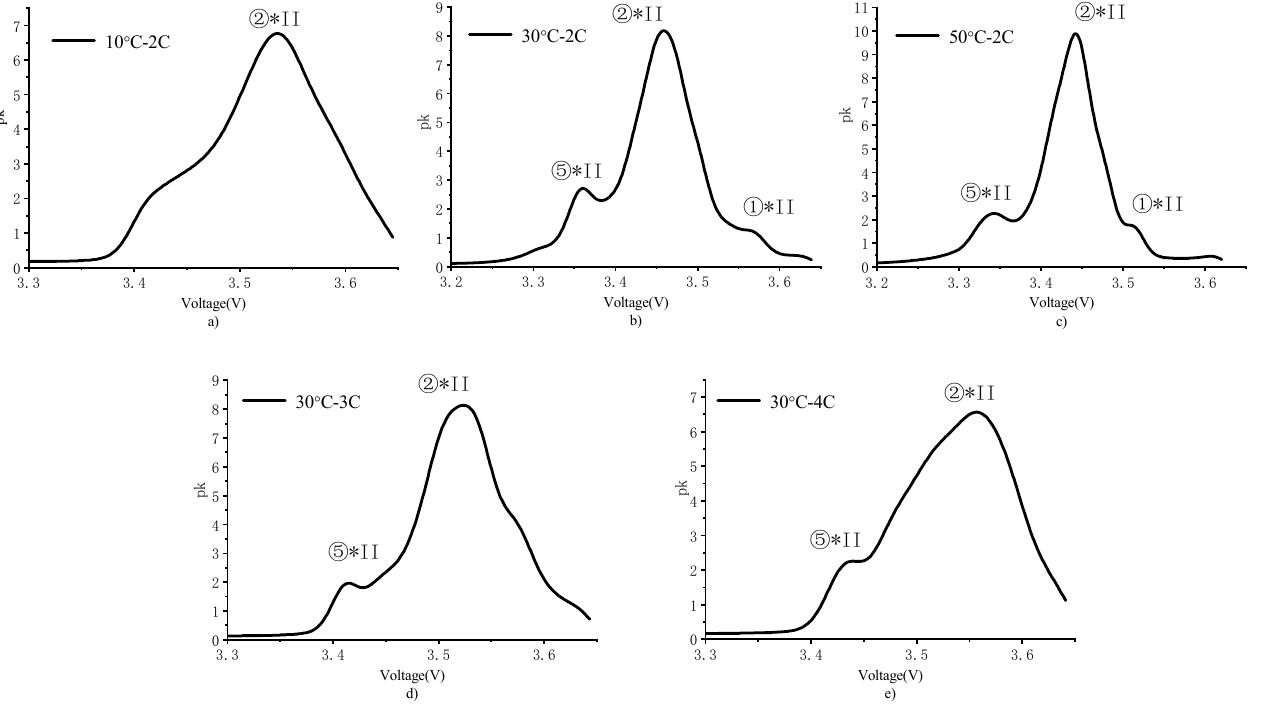
Figure 8. PDF curves at different temperatures and charging rates. ( a ) PDF curves at 10 ° C and 2C charging rate; ( b ) PDF curves at 30 ° C and 2C charging rate; ( c ) PDF curves at 50 ° C and 2C charging rate; ( d ) PDF curves at 30 ° C and 3C charging rate; ( e ) PDF curves at 30 ° C and 4C charging rate.